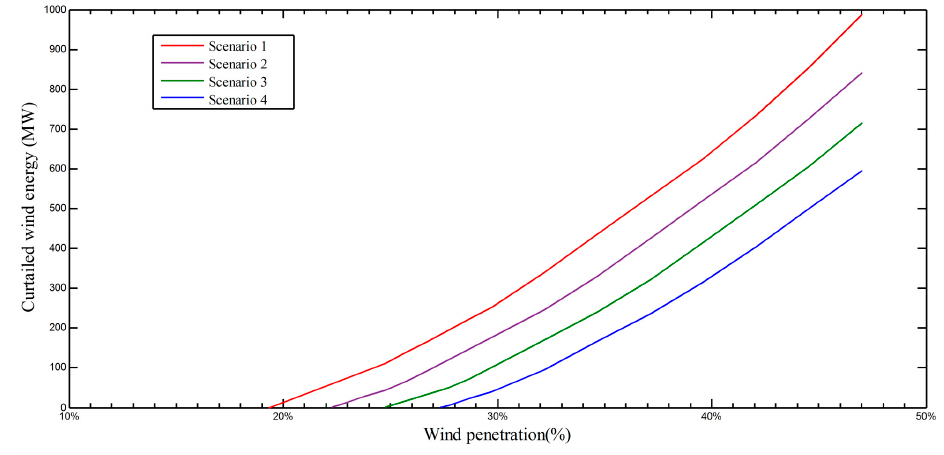
Figure 12. Wind power curtailment at different wind penetration levels in the four scenarios.